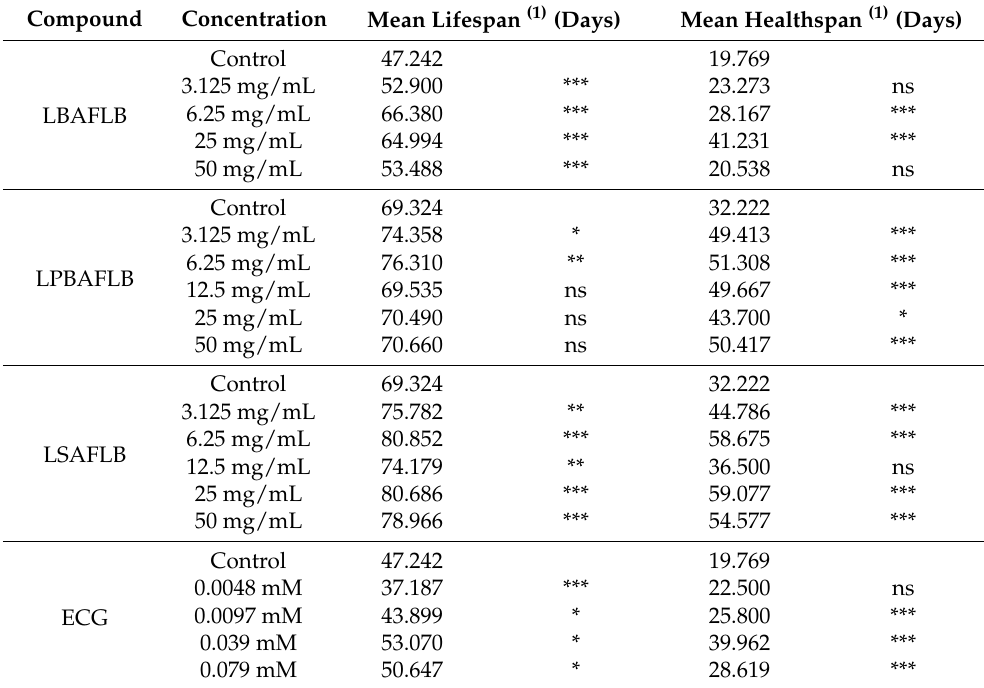
Table 4. Mean and significancy of curves for lifespan and